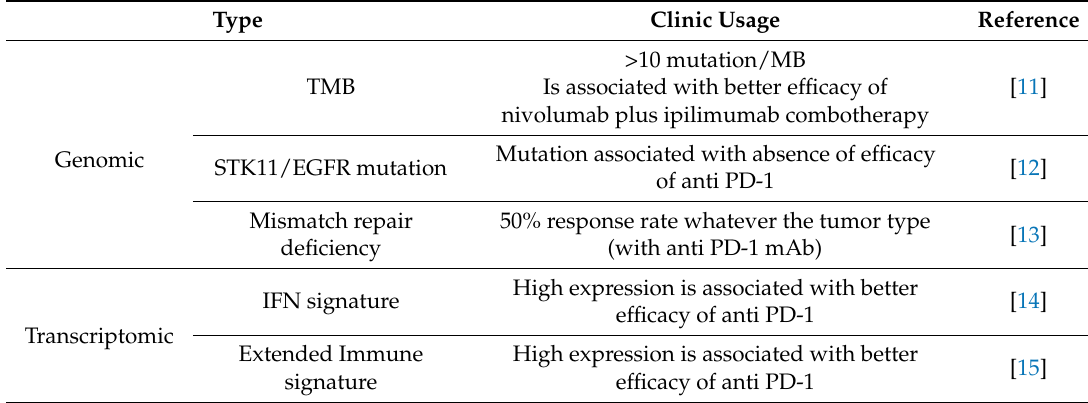
Table 1. Summary of the different genomic and transcriptomic biomarkers available for